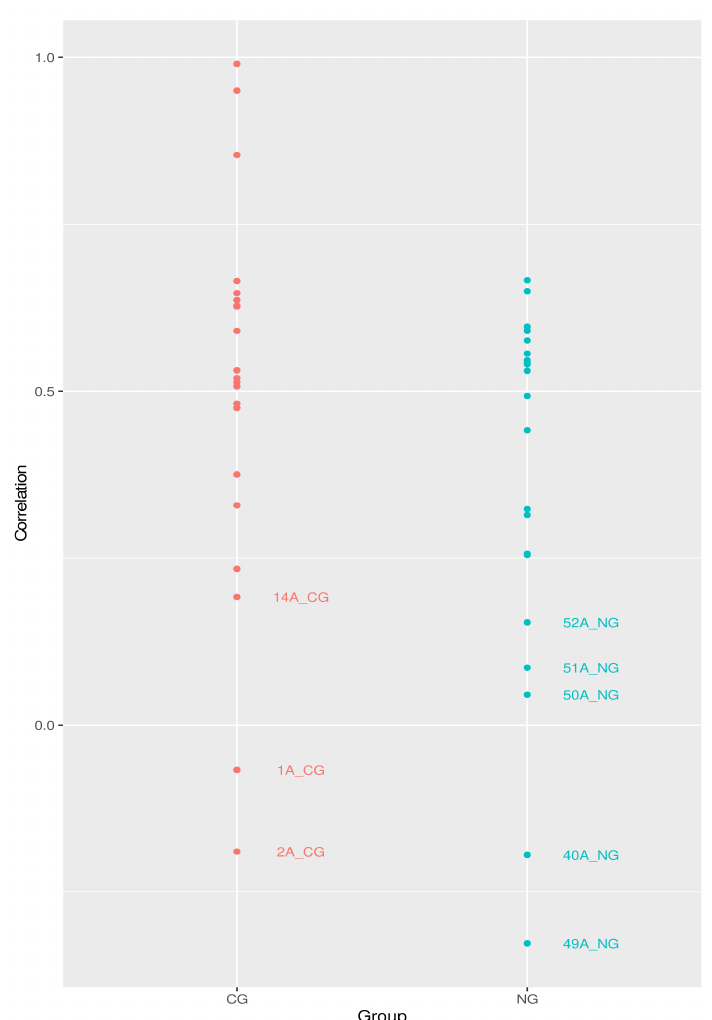
Figure 2. Correlation between the FISH-based and NGS-based relative abundances of the selected microbial species. The plotted value is the Pearson coefficient between the species quantities in each sample. Samples with R 2 < 0.2 are